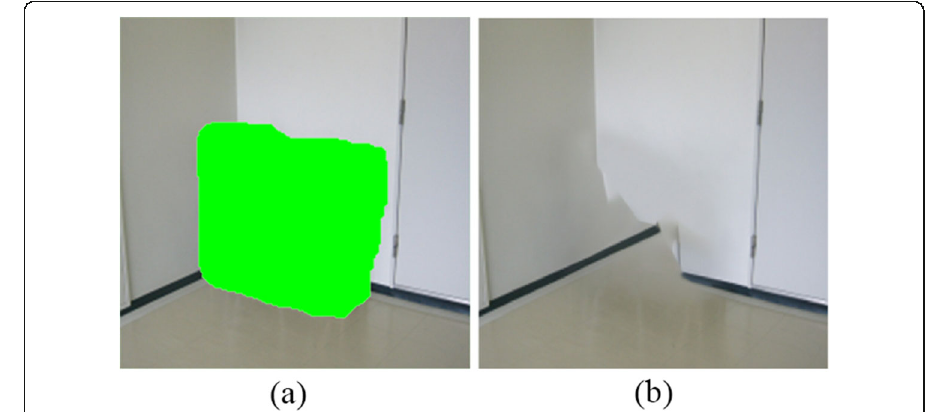
Fig. 14 Failure. a Input. b Our